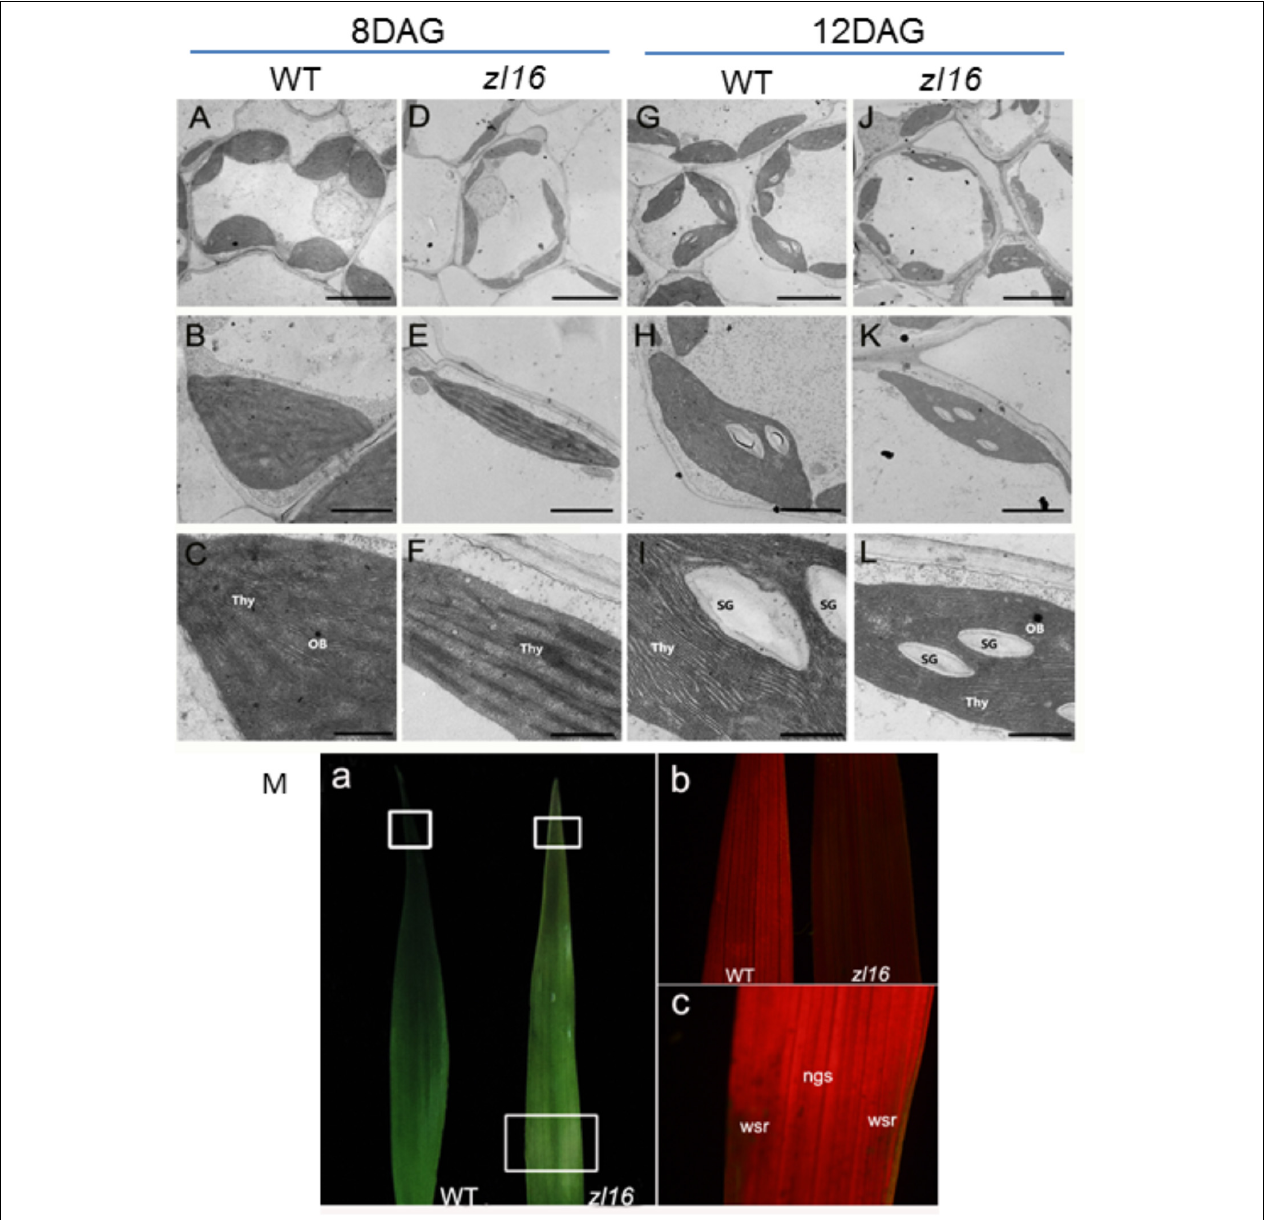
FIGURE 2 | Ultrastructure of the chloroplast and chlorophyll autofluorescene observations of wild type (WT) and zl16 mutant. (A–L) Transmission electron micrographs (TEM) images of WT ( A–C and G–I ) and zl16 ( D–F and J–L ) chloroplasts. Seedlings were grown for 8 and 12 days after germination, respectively. OB, osmiphilic body; SG, starch granule; Thy, thylakoid lamellar. Bars: 2 µ m (A,D,G,J) , 1 µ m (B,E,H,K) , and 0.5 µ m (C,F,I,L) . (M) Observation of autofluorescence of leaves. Panel a , observation of leaves under natural light conditions. The boxes in the upper and lower parts denote the regions that were enlarged in panel b and c , respectively. Panel b , autofluorescene of leaf tips from wild-type and zl16 seedlings under UV light, respectively, at 8-d after germination. Panel c , autofluorescene from the white striped regions (wsr) and normal green sectors (ngs) in the zl16 mutant seedlings under UV light, respectively.